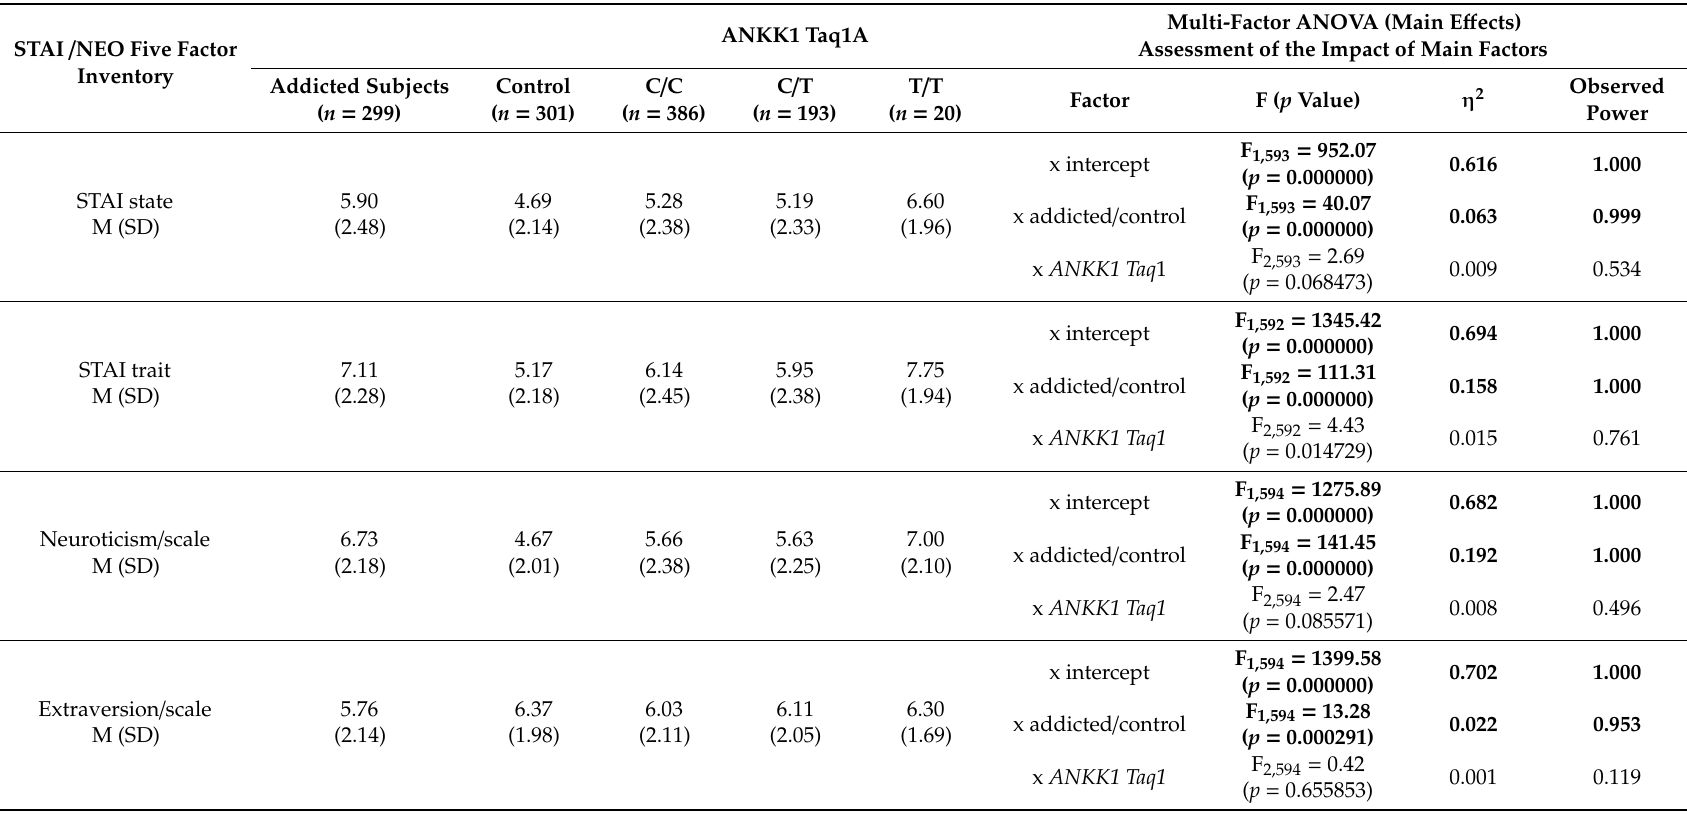
Table 4. Di ff erences in ANKK1 Taq1A and STAI, NEO Five Factor Inventory between healthy control subjects and addicted